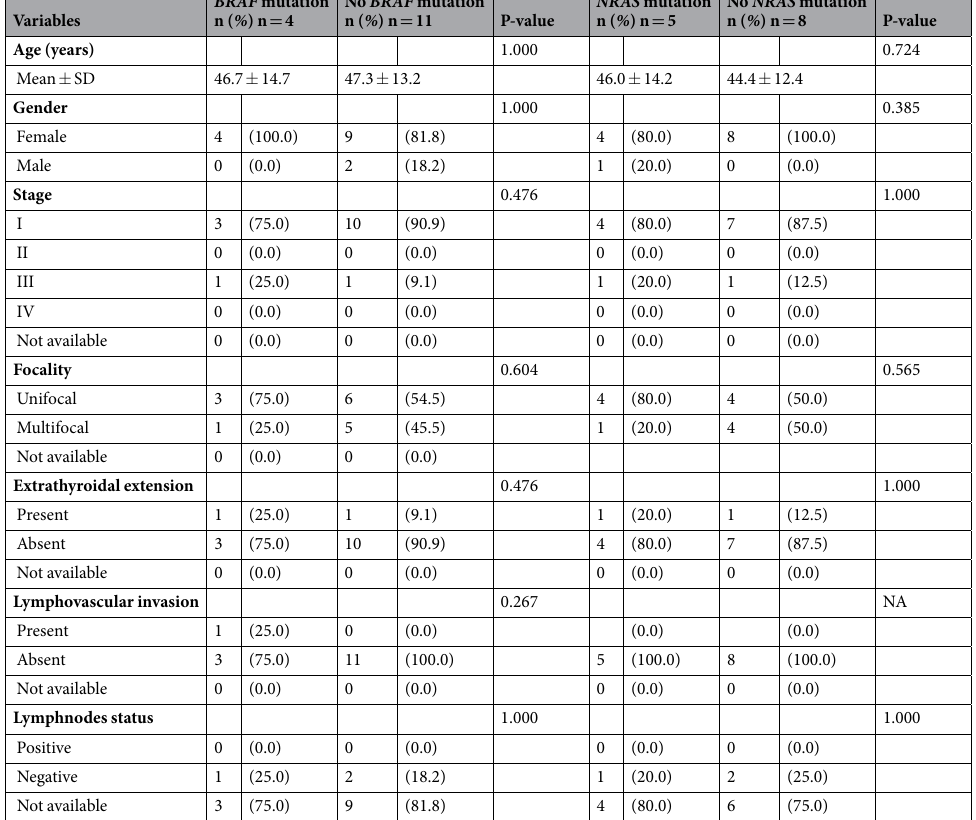
Table 4. Clinicopathological features of PTMC-FV cases with respect to BRAF and NRAS mutations. * Significant